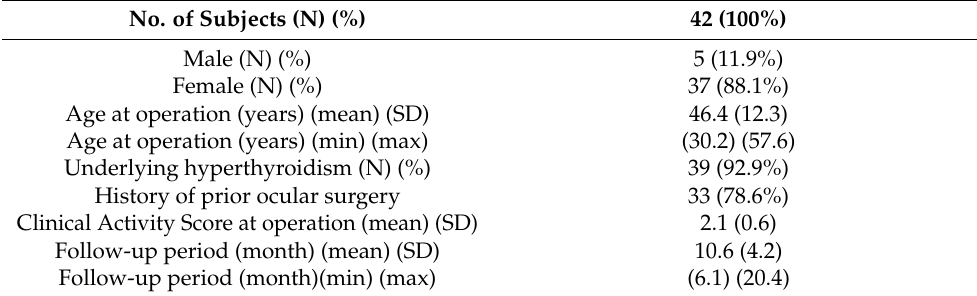
Table 1. Demographic characteristics of the patients in the